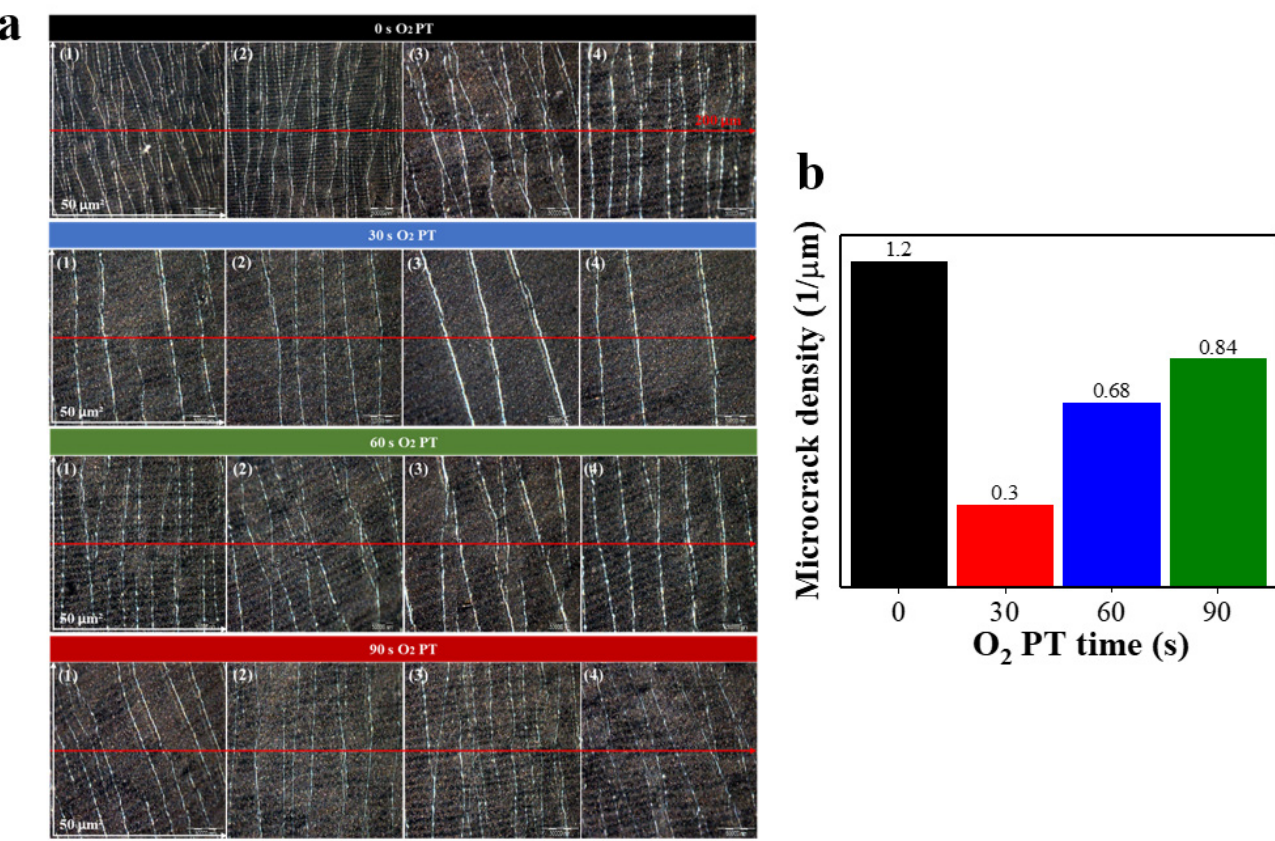
Figure 3. ( a ) Optical microscope top-view images of PPy films synthesized on PDMS substrates under four different PT time intervals of 0 (CS), 30, 60, and 90 s. A total of 500 cyclic loads of stretching (20%)/release were applied in advance to the PPy films before optical microscope observation. Micrographs were taken on four different areas (50 × 50 µ m 2 ) for each PT condition. ( b ) Bar-graphs illustrating the microcrack densities measured from the PPy films plasma-treated for different time intervals of 0 (CS), 30, 60, and 90 s. All the images were taken under the same uniaxial stretching condition (5%) to make the surface microcracks more